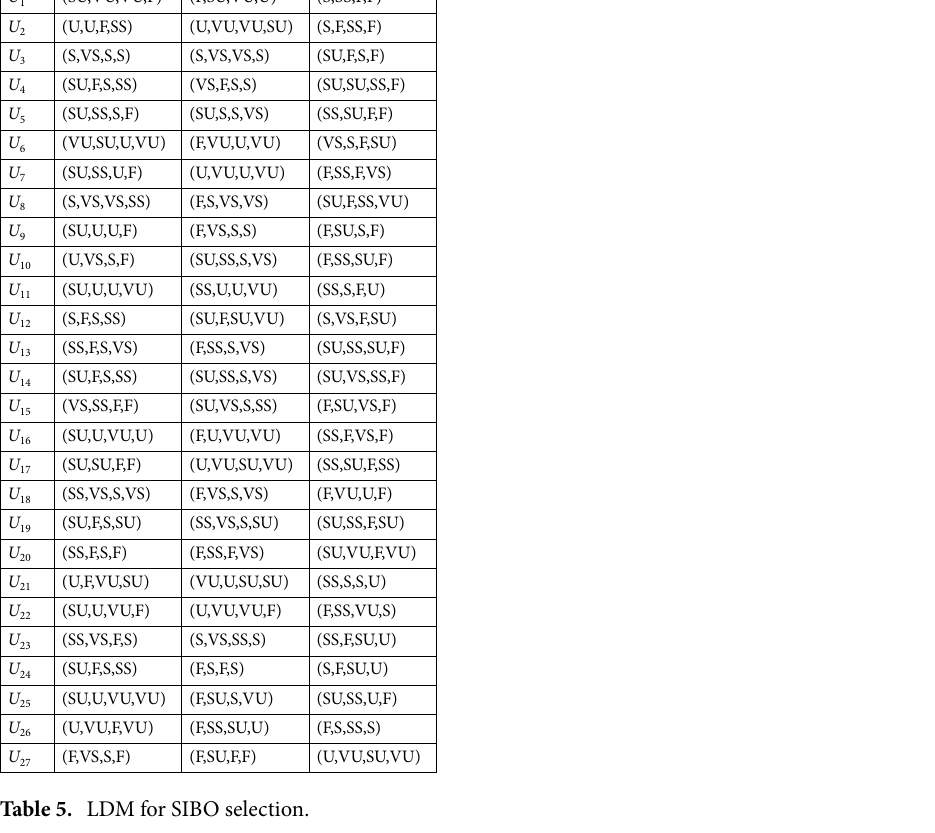
for each DME and are shown in Table 5. Using Eq. (6), Eq. (9) and Table 5, m × n (cid:30)